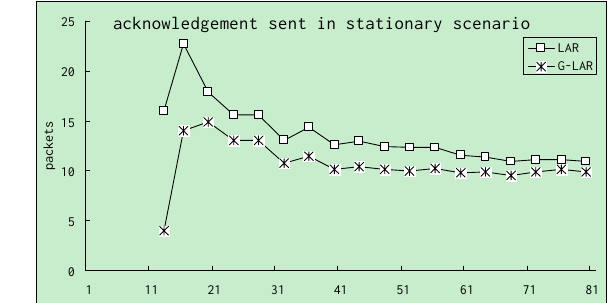
Fig. 7. Routing traffic sent in stationary scenario